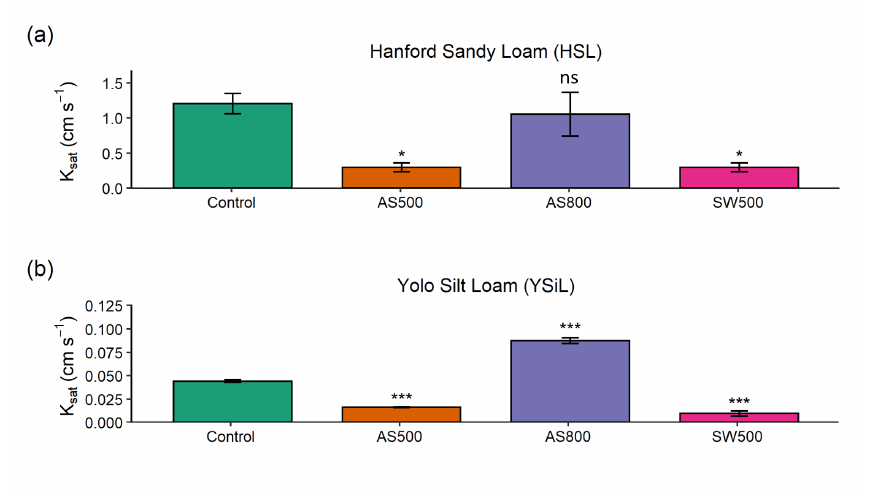
Figure 3. Impact of 0% and 2% addition of AS500, AS800, and SW500 biochars on saturated hydraulic conductivity ( K sat ) in (a) a Hanford Sandy Loam (HSL) soil and (b) a Yolo Silt Loam (YSiL) soil ( n = 5). Symbols denote significance levels as follows: n.s.: not significant, ∗ p < 0 . 05, ∗∗ p < 0 . 01, and ∗∗∗ p < 0 . 001. P values refer to comparisons between treatments and the control within each pore volume and were corrected for multiple comparisons using Tukey’s HSD